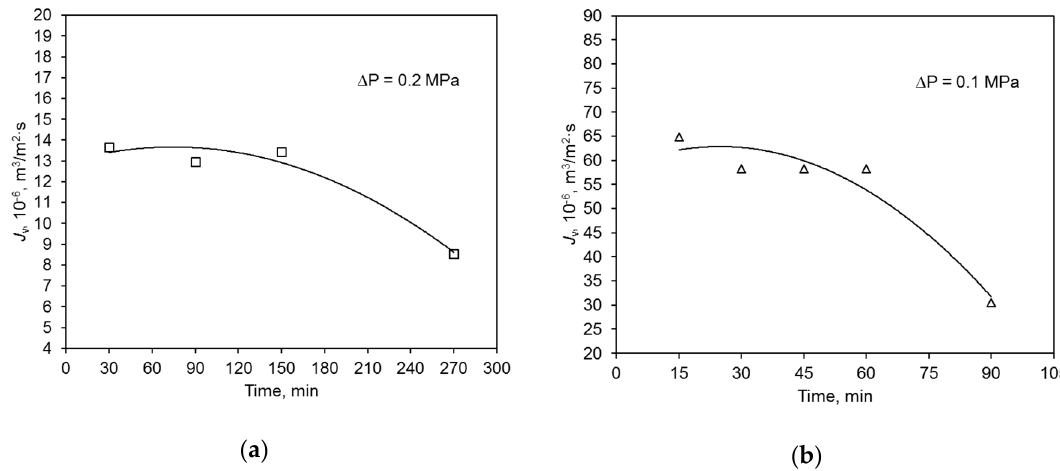
Figure 4. Change of hydraulic membrane capacity during swimming pool water filtration: ( a ) polymer membrane, ( b ) ceramic membrane. Table 3. Transport properties of membranes during swimming pool water treatment. VRR—volume reduction ratio.